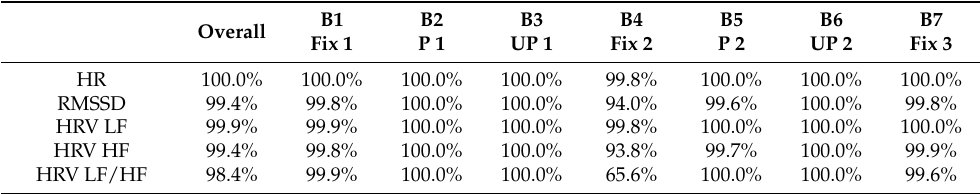
Table 6. Lower CI in percent for each block and dependent